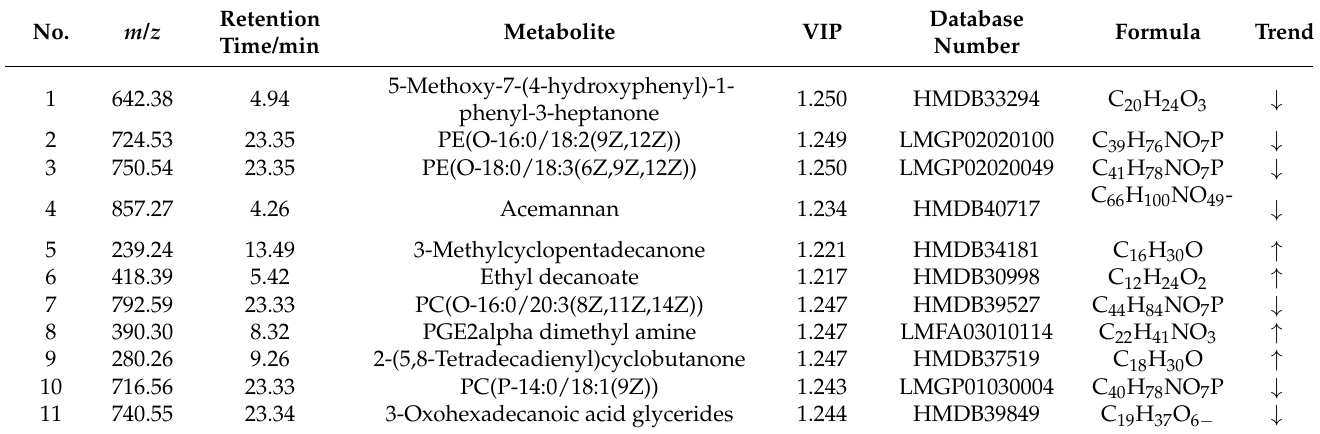
Figure 6. Volcanic diagram of pairwise comparison of differential metabolites and the metabolic pathways of THP-1 after treatment with the three main SCFAs. Table 1. Potential differential metabolites between the ox-LDL and NaAc groups.